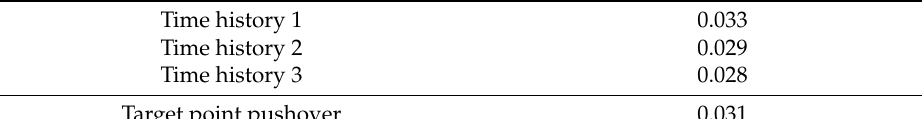
Table 7. Maximum S d (m) for case study 2.